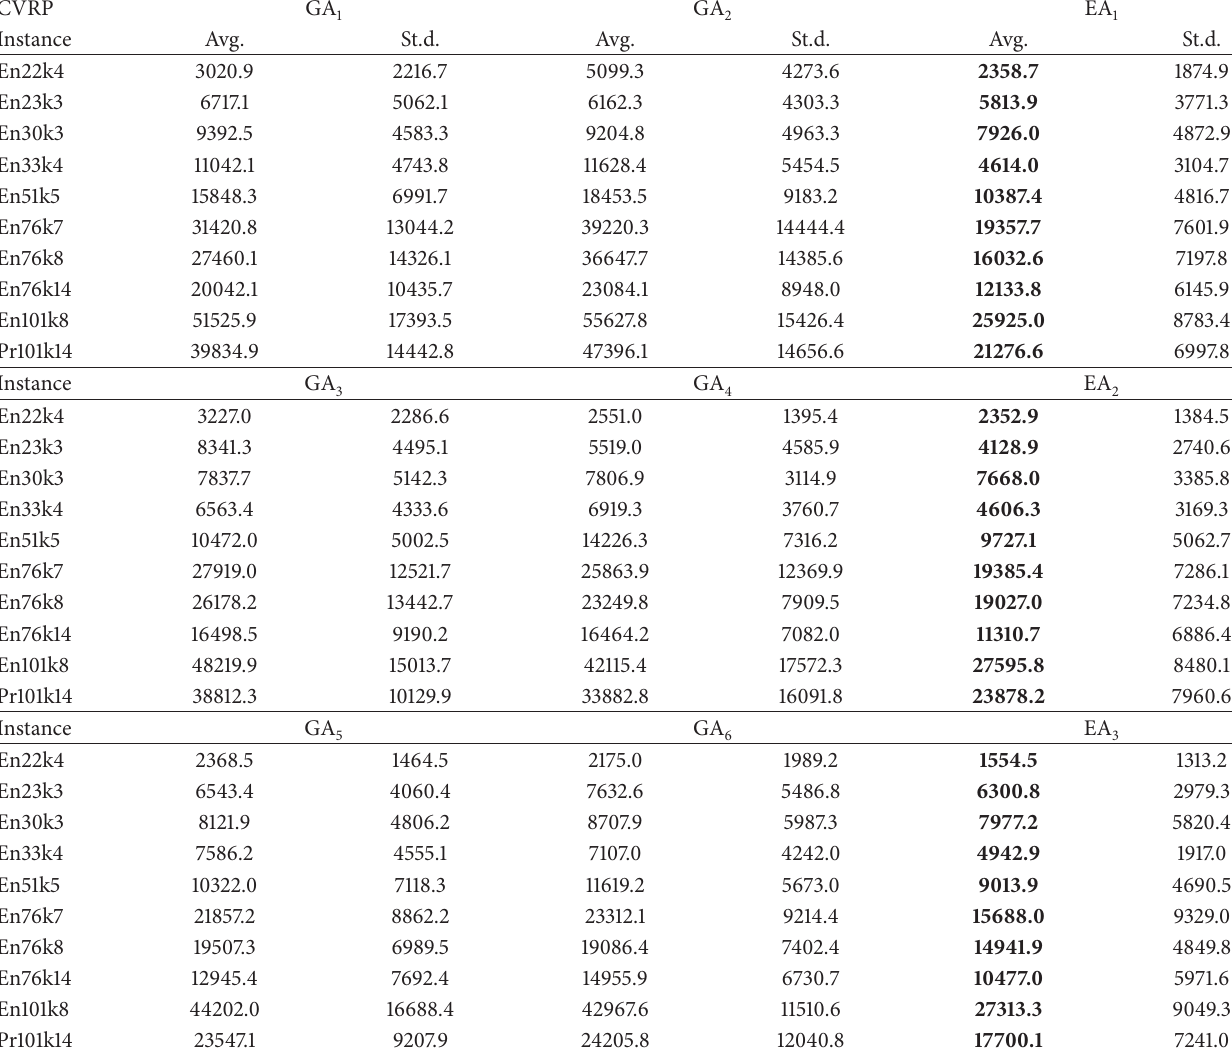
Table 6: Convergence behaviour of the nine techniques applied to the